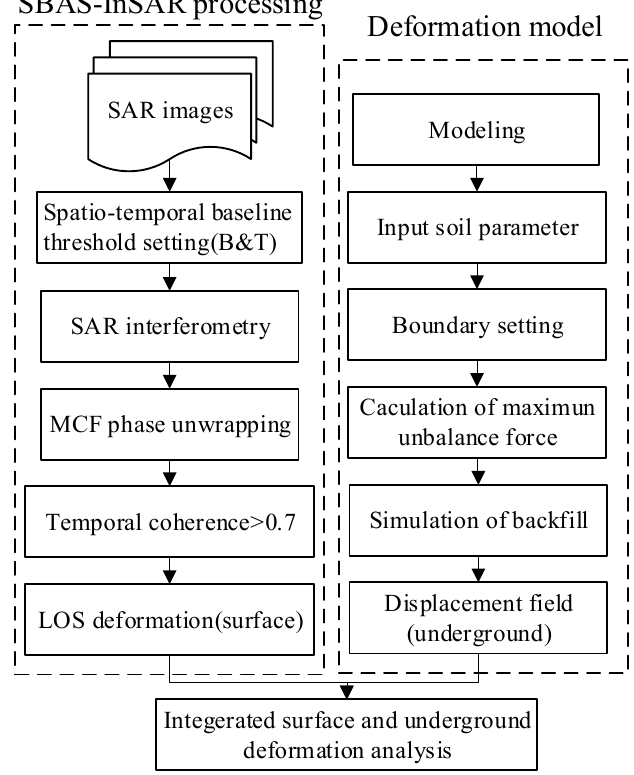
Figure 3. Flowchart. Figure 3.